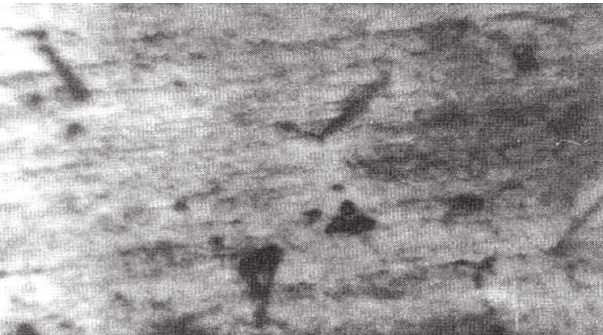
Figure 6. Micrograph of welded sample subjected to voltage V processing